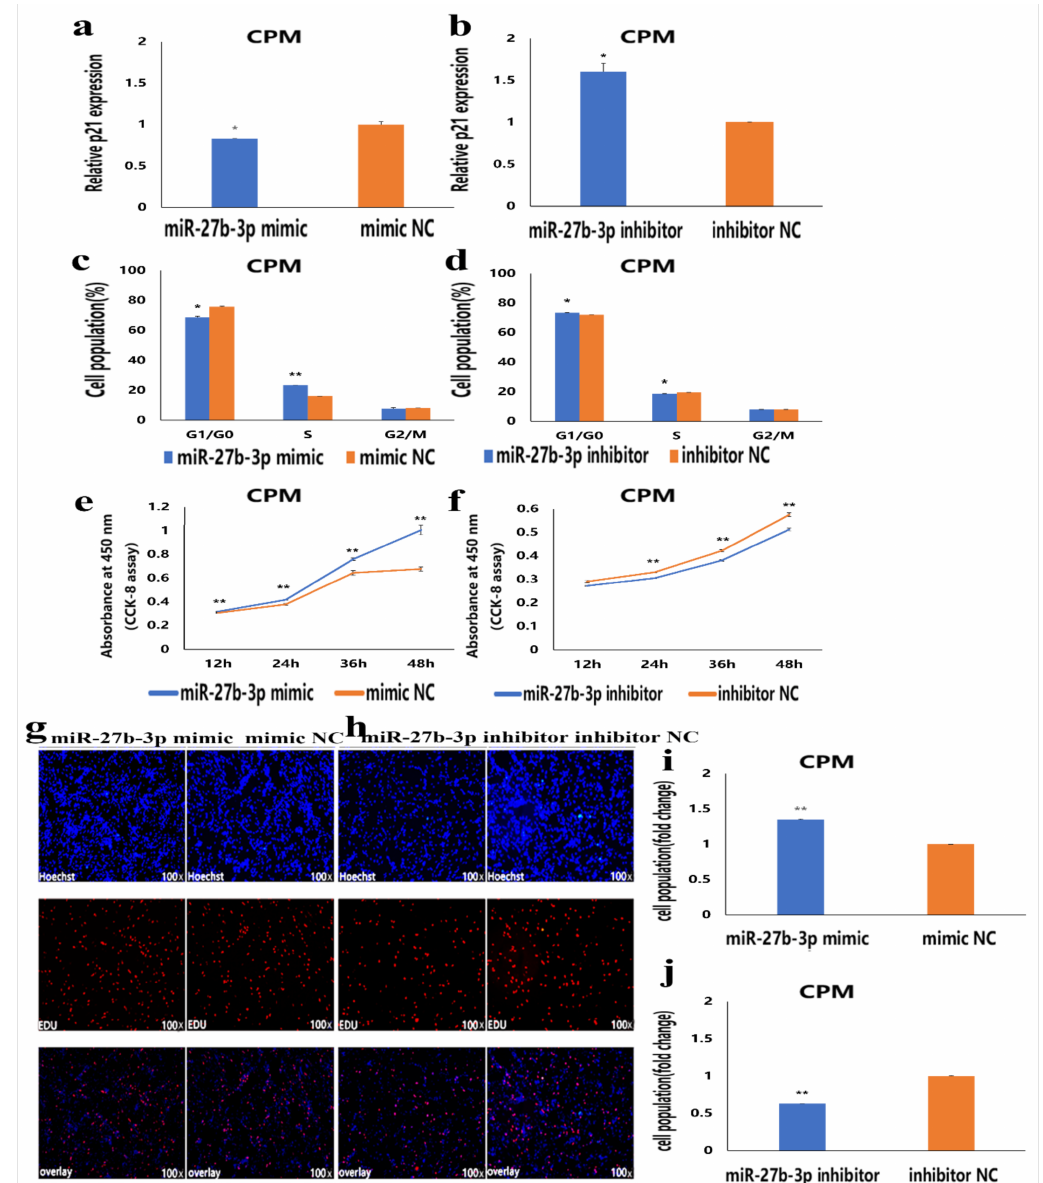
Figure 2. The proliferation of chicken primary myoblasts (CPMs) is promoted by miR-27b-3p. ( a , b ) The relative mRNA expression of p21 after transfection with miR-27b-3p mimic and inhibitor in CPMs. ( c , d ) Cell-cycle analysis of CPMs 48 h after transfection with miR-27b-3p mimic and inhibitor in CPMs, using propidium iodide staining for DNA content. ( e , f ) Cell growth was measured following the transfection of miR-27b-3p mimic and inhibitor in CPMs. ( g , h ) The proliferation of CPMs following the transfection with miR-27b-3p mimic and inhibitor was assessed by EdU incorporation. Microscopic images were obtained by a fluorescence inverted microscope (dmi8, Leica, Germany). ( i , j ) Proliferation rates of CPMs following transfection with miR-27b-3p mimic and inhibitor. In all graphs, the results are shown as mean ± SEM (standard error of the mean) ( n = 3). Statistical significance of differences between means was assessed, using the unpaired Student’s t -test (* p < 0.05; ** p < 0.01) vs. NC (negative